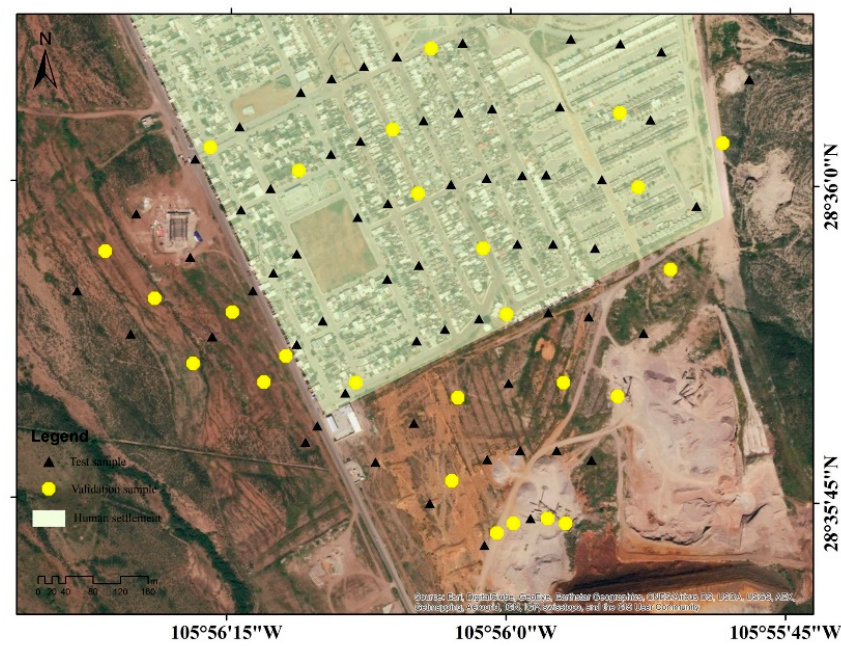
Figure 4. Test and validation points of the interpolations in P1 and P2. ▲ = test sample, ● = test validation.